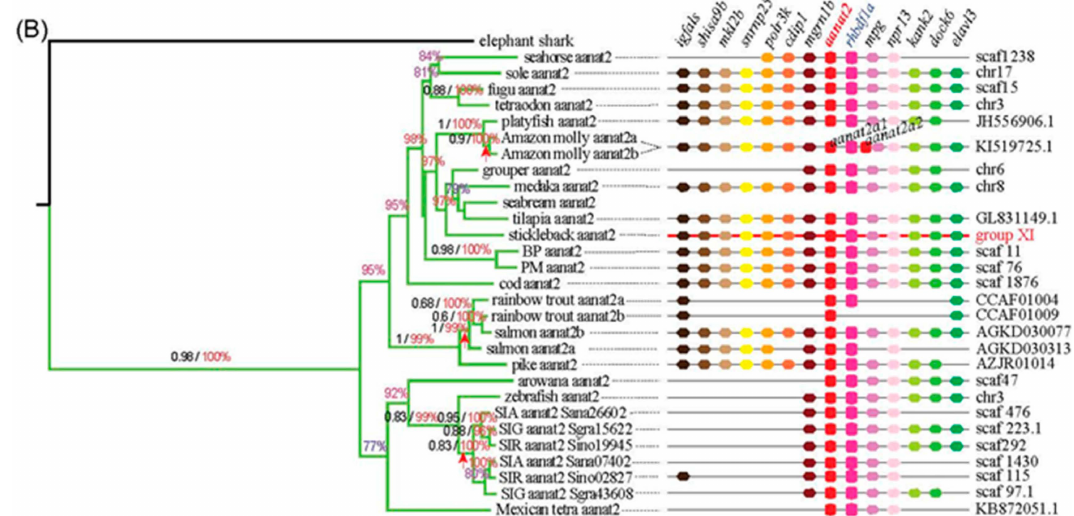
Figure 3. Phylogenetic trees and synteny of aanat1 ( A ) and aanat2 ( B ). The left of ( A , B ) are rectangular Bayesian trees of aanat1 and aanat2 , respectively. Numbers on branches from left to right are bootstrap supports (black) obtained in the phyML reconstruction and the Bayesian posterior probabilities (colored). The symbol of arrow represents the whole genome duplication. Note that bootstrap support under 0.6 and posterior probabilities under 70% are not shown. The color of branches is similar to Figure 2; The right of ( A , B ) are synteny of aanat1 and aanat2 , respectively. Distances between genes or gene length are not drawn to scale. In mammals, four genes ( srp68, evpl, ten1, acox1 ) are located 400-kb upstream of aanat within several genes intervening (shown with a red broken line). Stickleback aanat1a , shown with a red backbone, is used as the reference